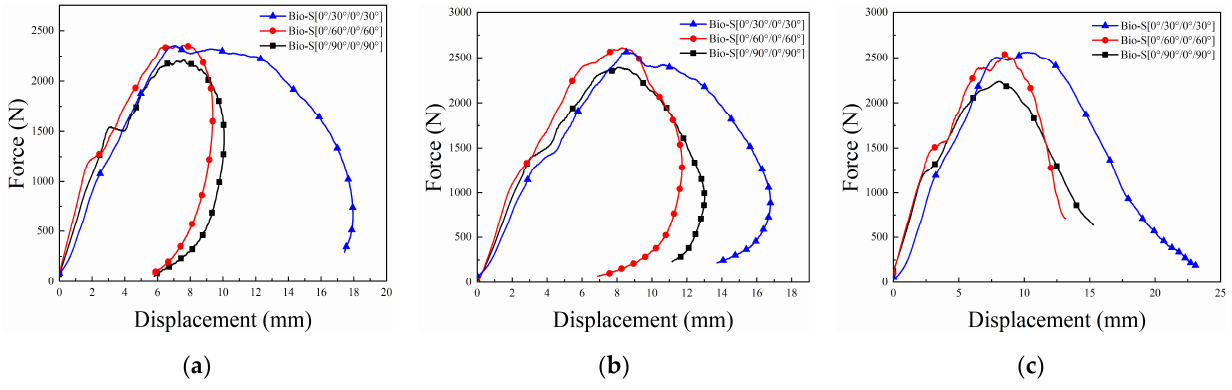
Figure 14. Force-displacement curves of the Bio-S composite plates with different angles of middle layer configurations under different impact energy levels: ( a ) 15 J; ( b ) 20 J; ( c ) 25 J.